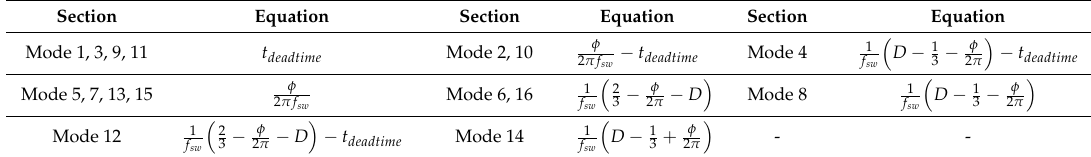
Table 1. Time equation depending on mode.